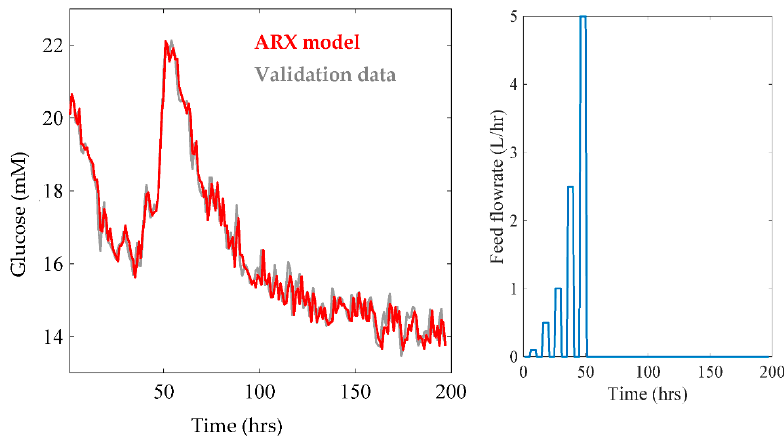
Figure 2. The glucose concentration and feed flowrate in the ARX data training.